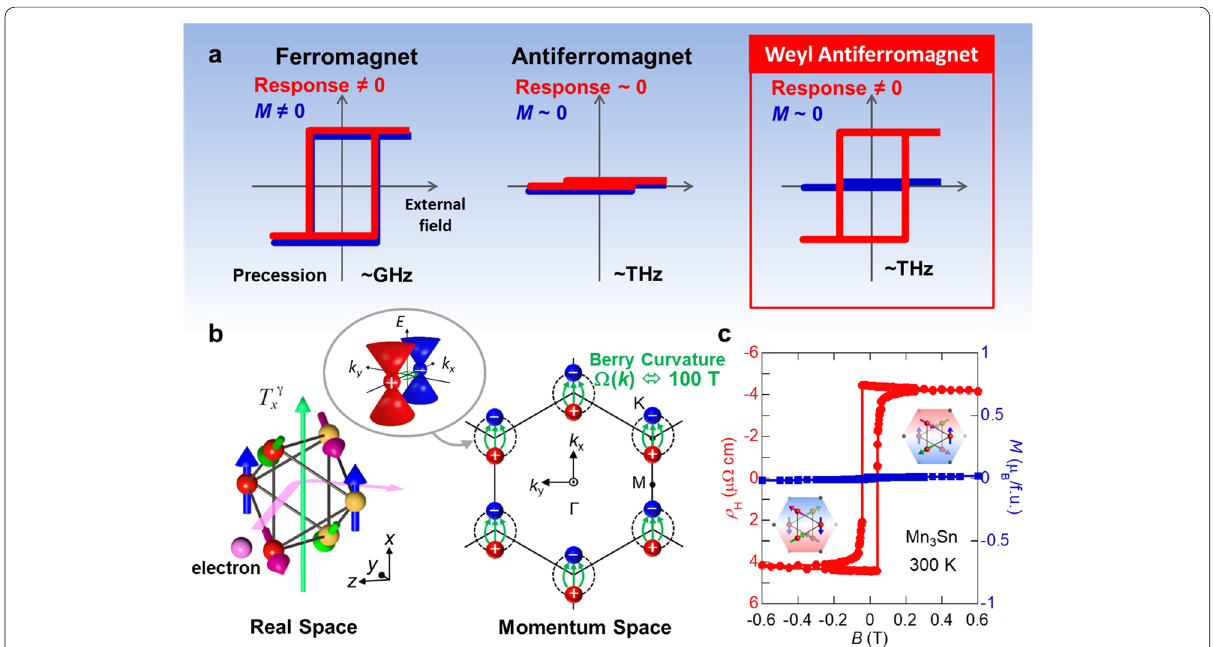
Fig. 1 The Weyl antiferromagnet and its functions: a Ferromagnet: Exhibits a large response proportional to its magnetization and has a GHz operation speed. Conventional antiferromagnet: Magnetization is very small if any, and the response is proportionally small. Weyl antiferromagnet: Despite its low magnetization, it exhibits large electrical, magnetic, and optical responses and presents THz operation speed. b Weyl antiferromagnet Mn 3 Sn: Real space: six Mn magnetic moments form a magnetic octupole Tx γ . Momentum space: Magnetic poles are strongly distributed at the Weyl points in the plane, and large fictitious magnetic fields (Berry curvature Ω (k ), green arrows) are produced. The dotted lines conceptually illustrate the trajectory (loop) on which the Weyl point moves when the octupole is rotated or flipped by the magnetic field or spin current. Inset: Schematic of linear dispersion near the Weyl point: The intersections of linear dispersions (Weyl points) always appear in pairs and are characterized by magnetic monopoles of different signs, i.e., and . c Anomalous Hall effect of Mn 3 Sn and magnetic field dependence of + − magnetization. The anomalous Hall effect (red, left vertical axis) changes sign corresponding to the inversion of the magnetic octupole (inset). Conversely, the magnetization (blue, right vertical axis) is approximately three orders of magnitude smaller than that of a ferromagnet (~1 m μ B